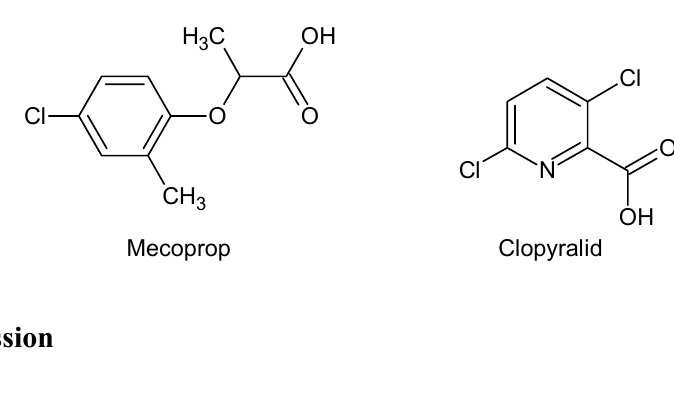
Figure 1. Structures of the pesticides.